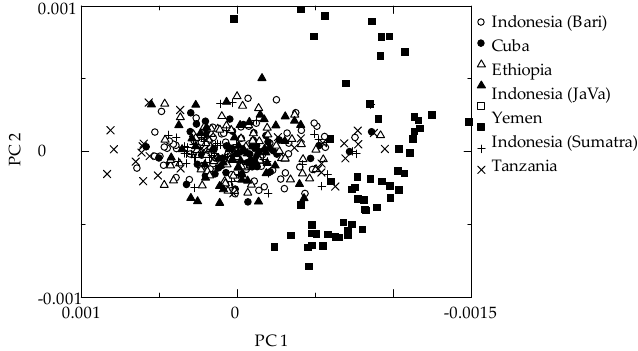
Figure 2. Score plot of PC1 versus PC2 for using pretreated NIR spectra.